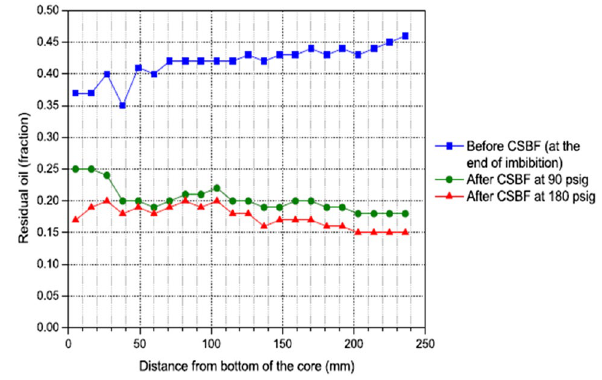
Fig. 10 Slice-averaged residual oil saturation (Alizadeh et al.